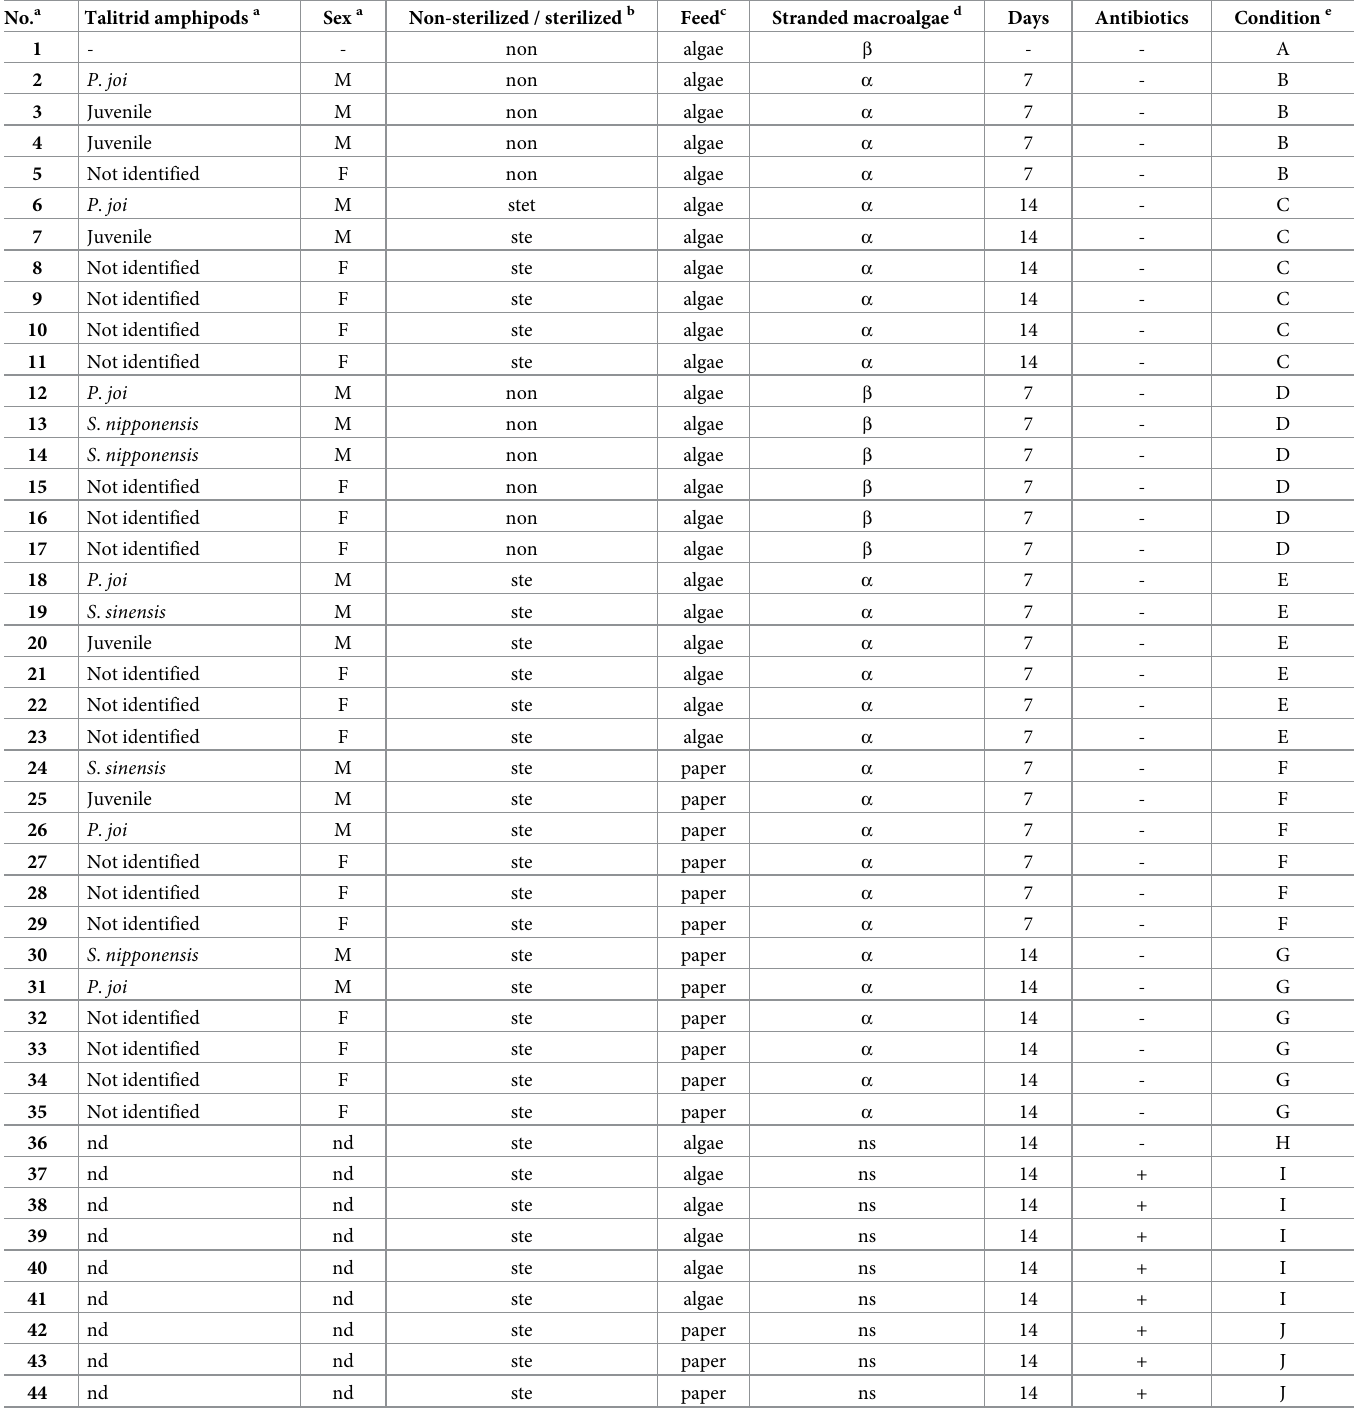
Table 2. Talitrid amphipods and conditions of housing of the amphipods for metagenomic analysis. No. a Talitrid amphipods